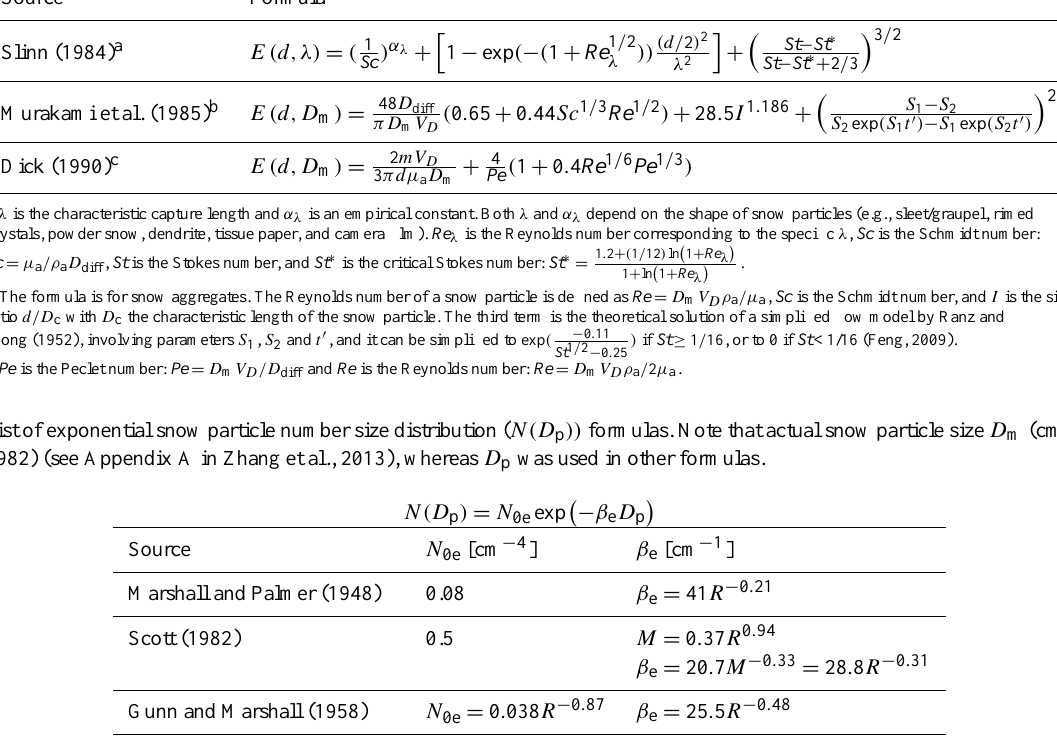
Table 4. List of semi-empirical formulas for snow particle–aerosol particle collection efficiency E . Source